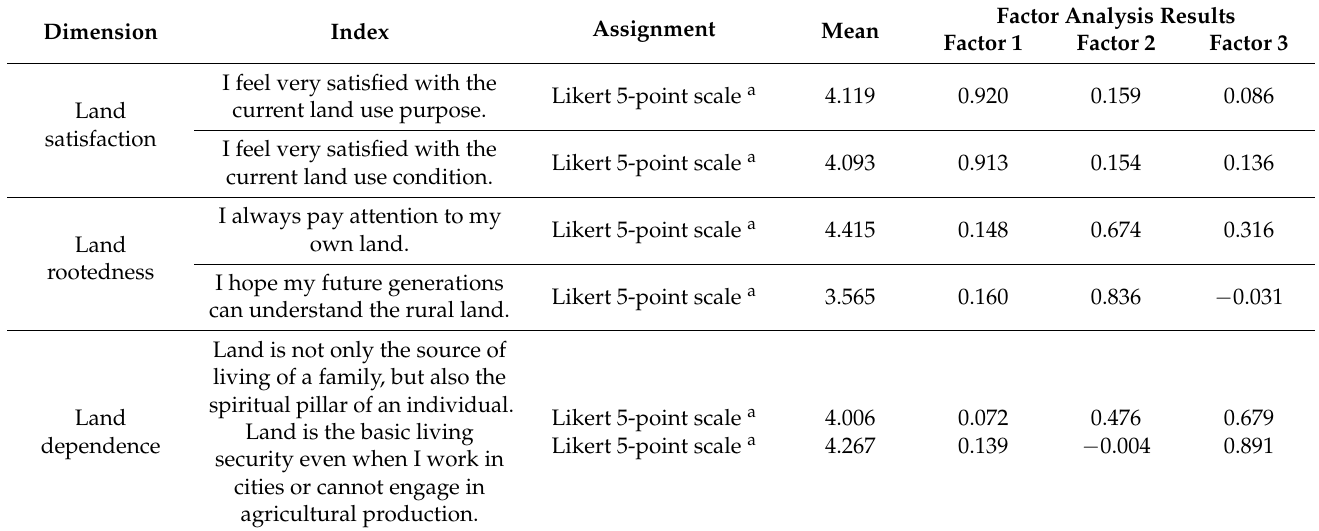
Table 1. Factor analysis results of land attachment.